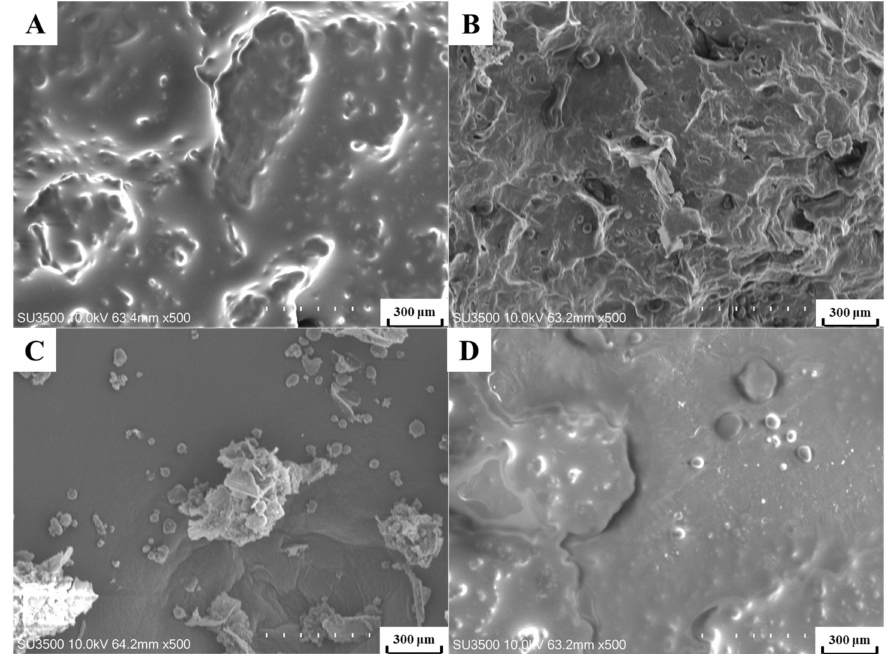
Figure 4. Scanning electron microscopy images of E. mollis powder: ( A ) Untreated, ( B ) UASEE residue, ( C ) SE residue, ( D ) CP